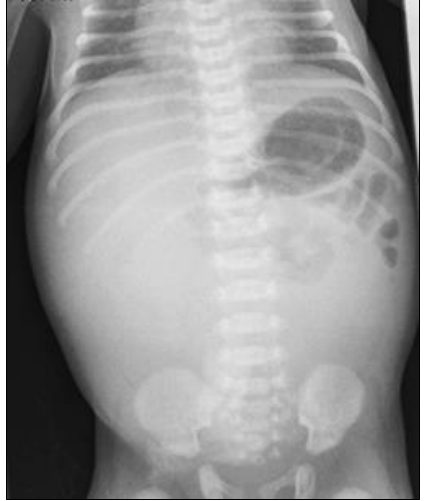
Figure 1: Plain X-ray of abdomen performed at 8 hrs. of age showing mass effect on the right side pushing bowel loops towards the left side with no free air in the peritoneal